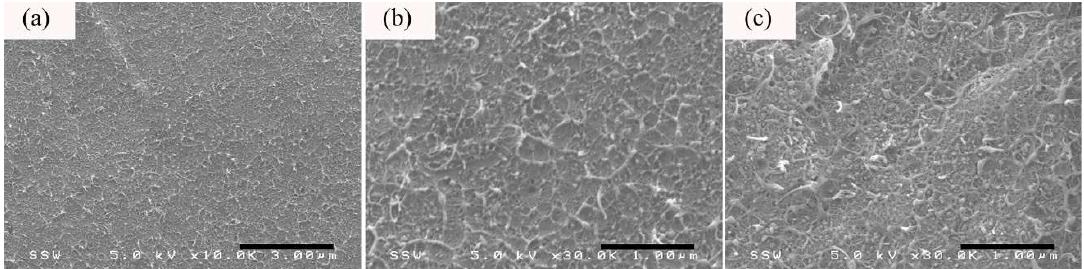
Figure 8. The morphology (TD) taken from the ( a , b ) core and ( c ) shear layers of the thick section of 5 wt %-PS/CNT50/CB50 microparts after the annealing treatment.